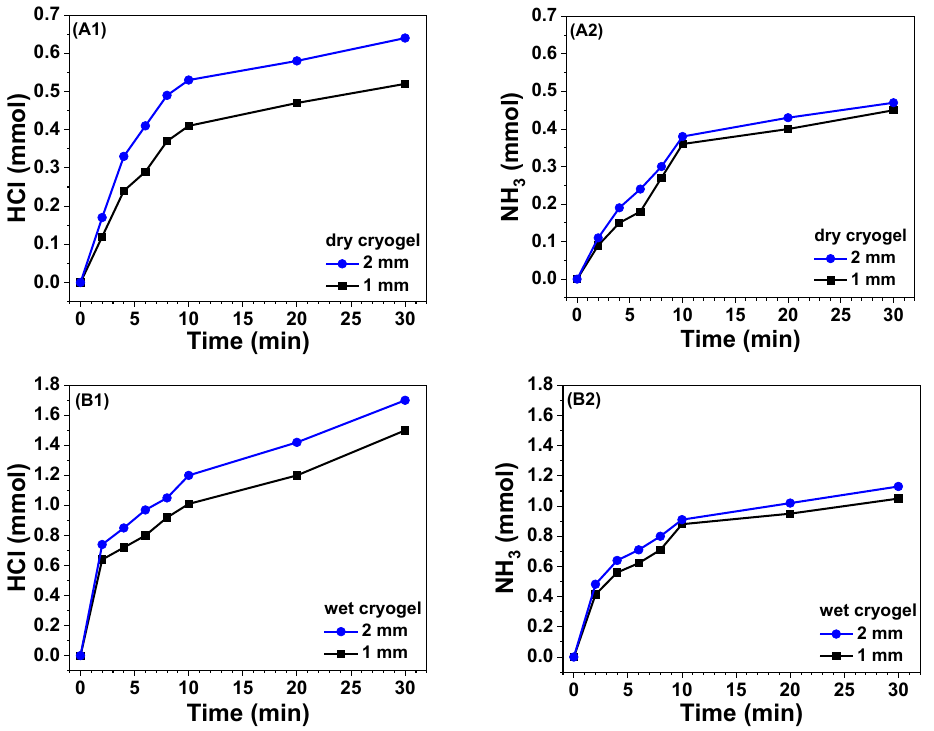
Figure 4. Variations of gas amount adsorbed by dried ( A ) and wet ( B ) sheets of 1/5-PA-PANI/PAAm Variations of gas amount adsorbed by dried ( A1 , A2 ) and wet ( B1 , B2 ) sheets of cryogel. 1/5-PA-PANI/PAAm